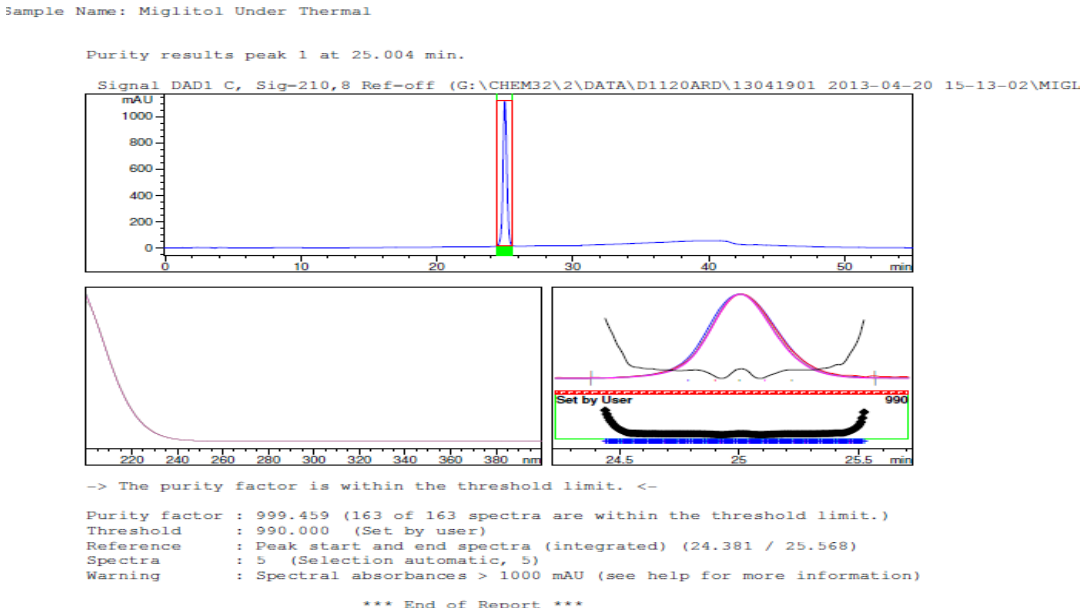
Figure 10. Peak purity in oxidative degradation by diode array detector.